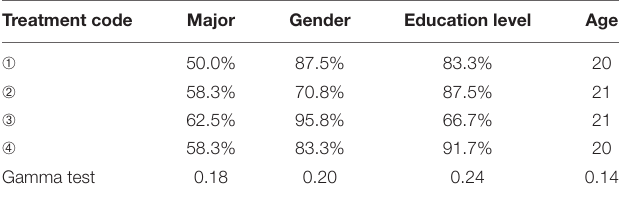
TABLE 4 | Demographic information of the four treatments.